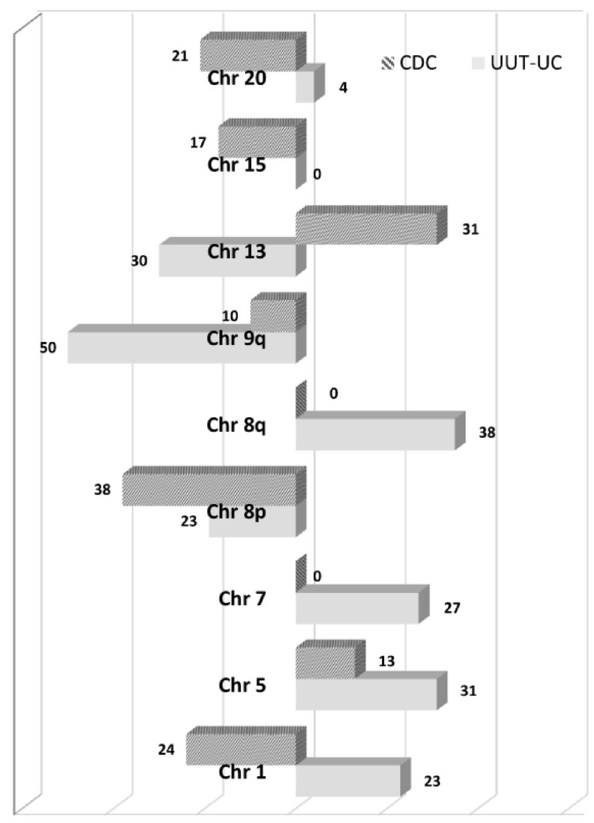
Figure 2. Comparison of chromosomal aberrations in CDC and UUT-UC tumors in percent. Losses of chromosomal material are shown on the left side, gains on the right